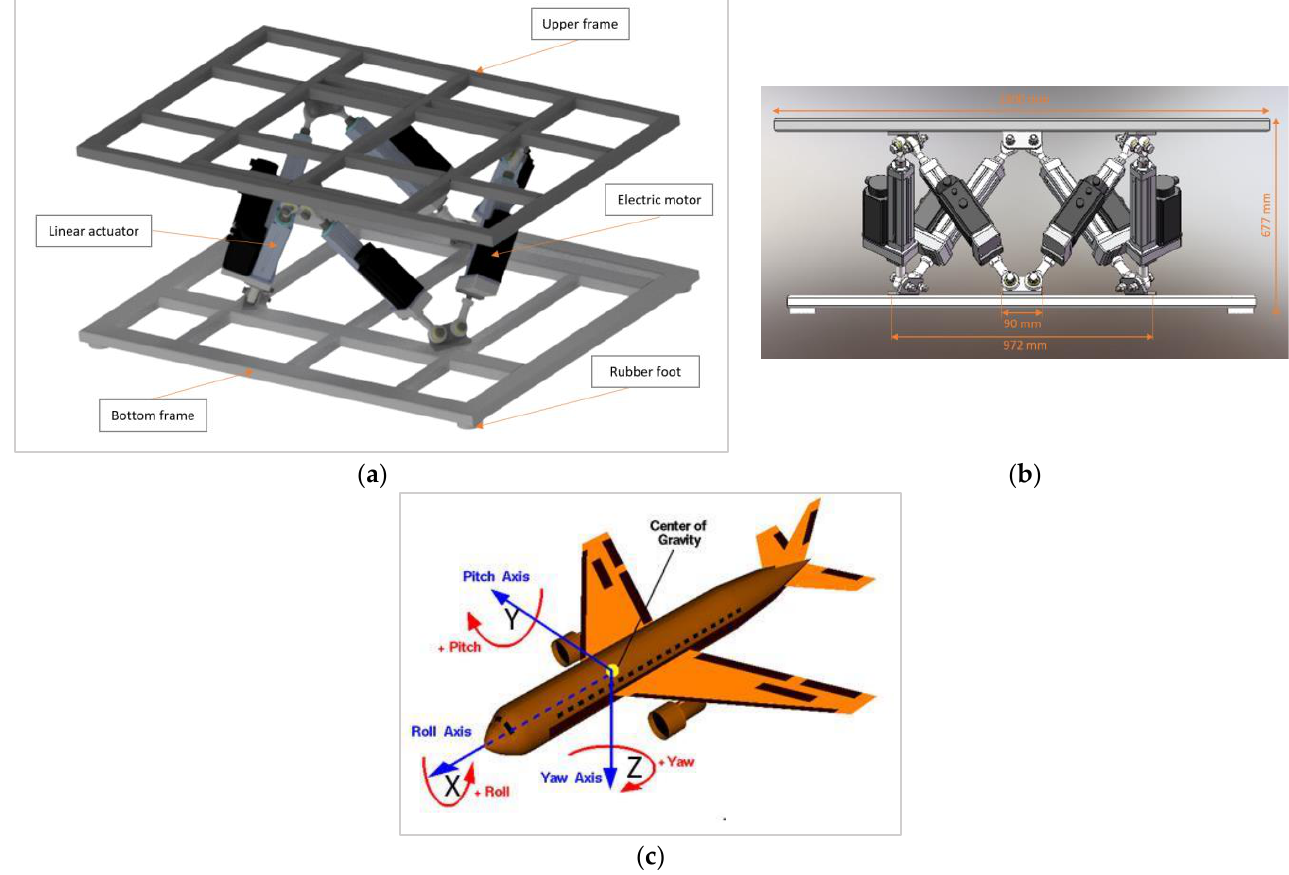
Figure 2. Illustration of the motion platform design with six degrees of freedom of the used simulator: ( a ) illustrates the hardware components of the platform; ( b ) illustrates the size of the platform; ( c ) illustrates the pitch, roll, yaw axes enabling 6-DOF motion of the